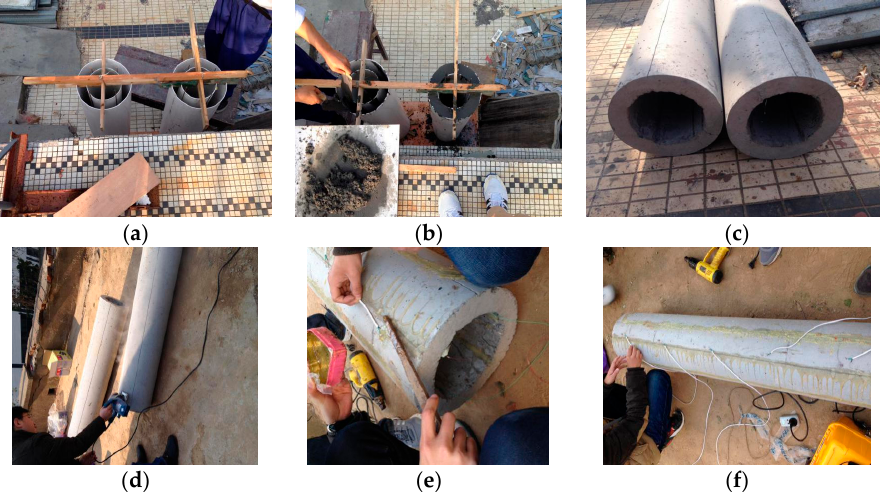
Figure 1. Process of fiber Bragg grating (FBG) sensor package. ( a ) Fixed the moulds; ( b ) Concreting; ( c ) the PCC model pile; ( d ) Fixed and Cut; ( e ) Fixed-point paste; ( f ) Comprehensive paste.